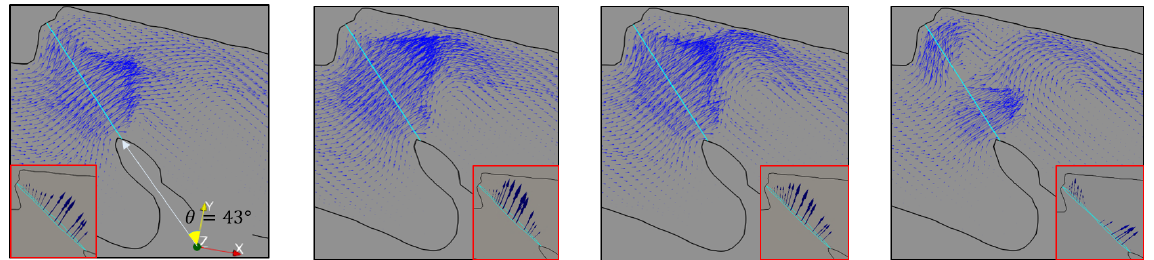
Figure 9. Time sequence of flow for Sample 3. Left to right: t = 0.56, 0.6, 0.64, and 0.66 cs. Inset figures show the corresponding glottal shape along with the velocity vectors through the